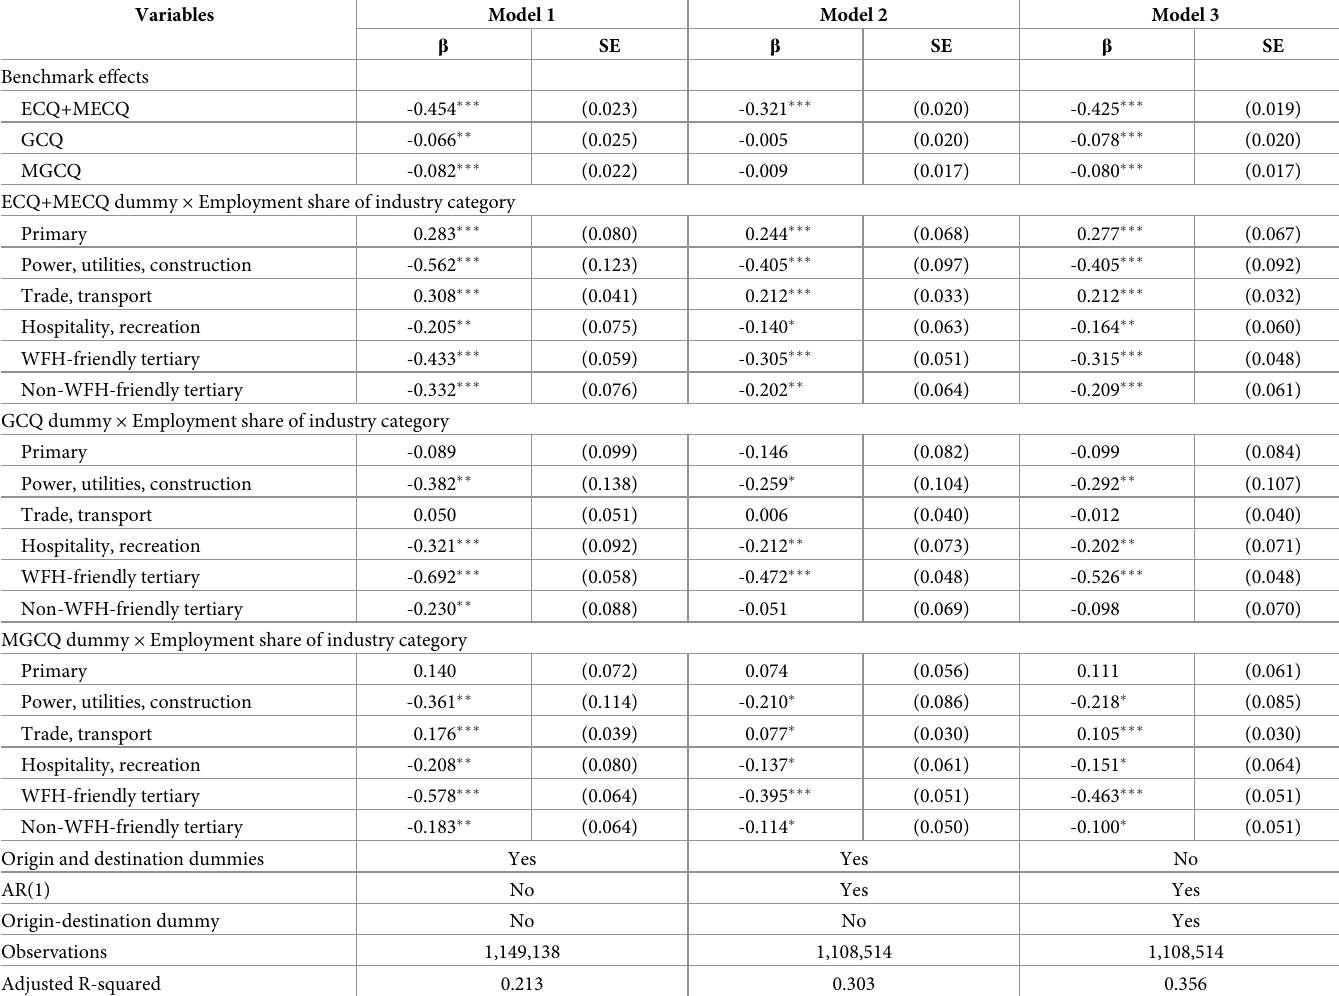
Table 4A. Effects of lockdown measures by destination city industrial composition (balanced panel of city